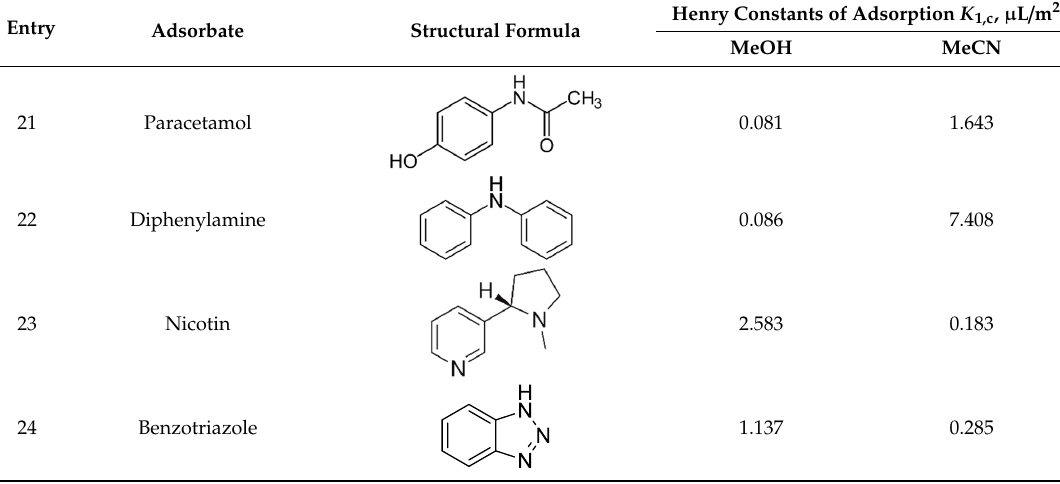
Figure 1. SEM micrographs of the HKUST-1 solv.1 ( a ), HKUST-1 solv.2 ( b ) and HKUST-1 mw ( c ) samples.